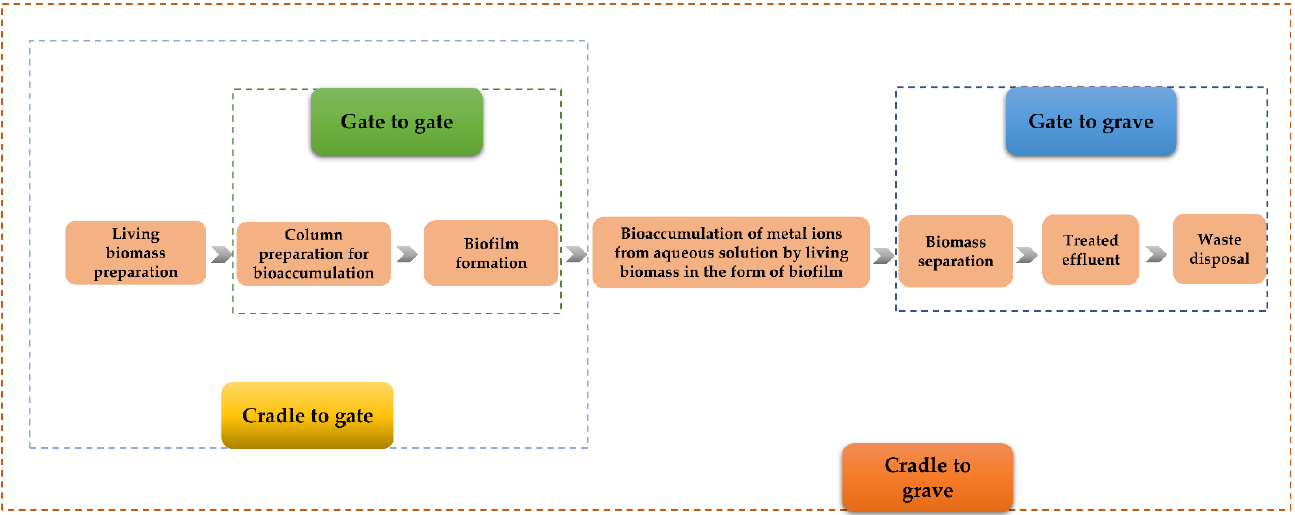
Figure 6. Defining system boundaries for the LCA of metal removal from wastewaters in continuous systems using microorganisms.